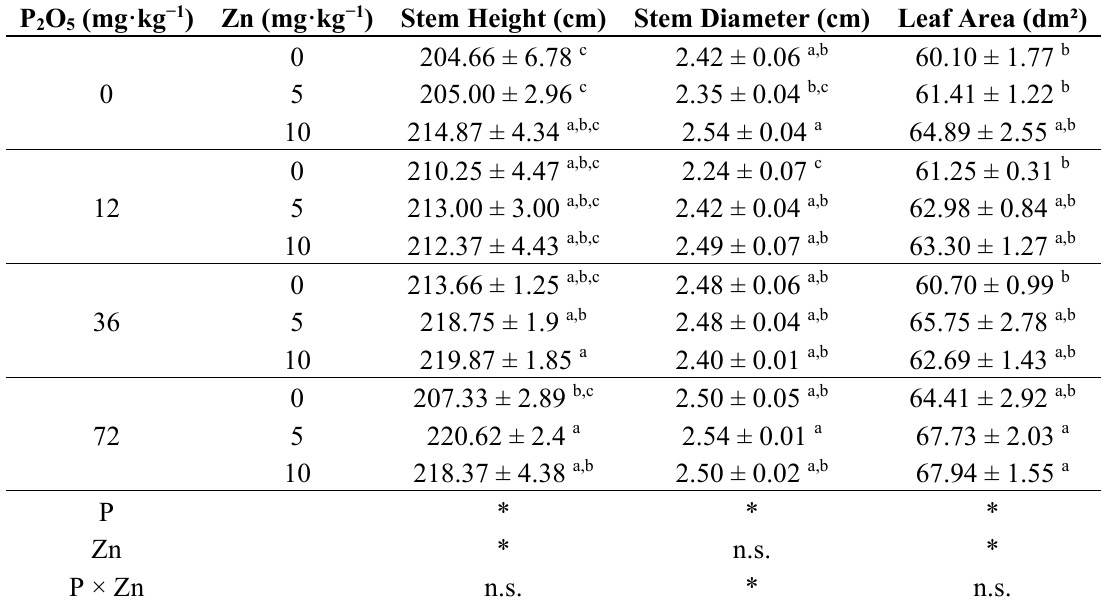
Table 2. Effect of zinc and phosphorus supply on stem height, stem diameter and leaf area of corn silage at